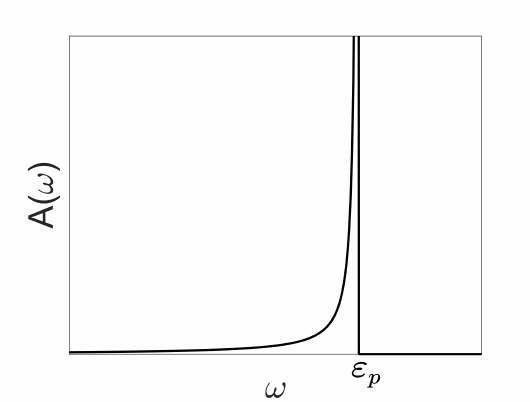
Figure 1: A plot of the spectral function A ( ω ) of fermions with power-law Green func- tions. The anomalous exponent α = 1.2. Other values of α in the range 0 < α < 2 have the same qualitative behavior for A ( ω )